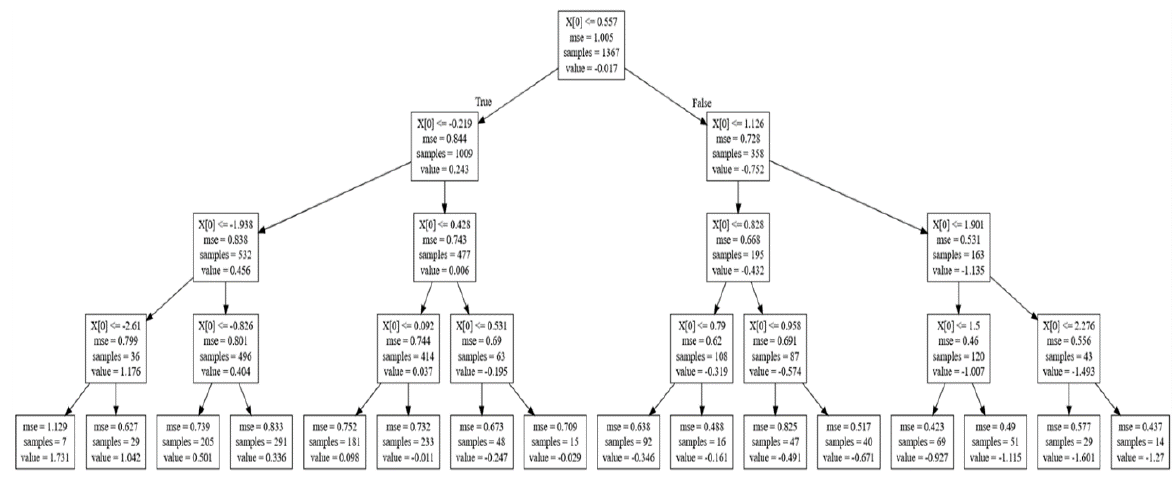
Figure 3. The generated decision tree graph.